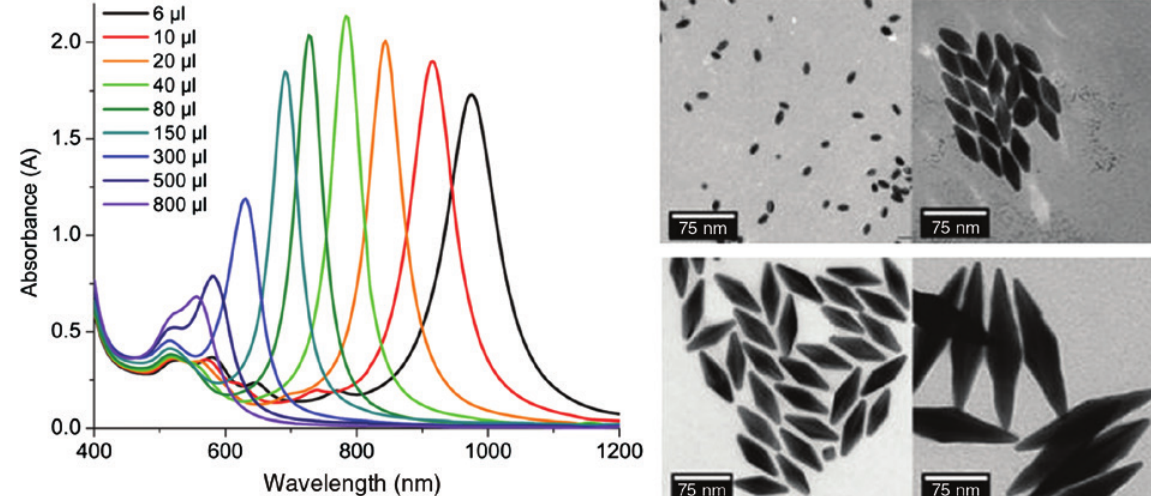
Figure 11: Left: Absorption spectra of the synthesized bipyramids versus the volume of seed solution added. Right: TEM of bipyramids prepared with CTAB and 800, 80, 40, and 6 μ l of seed suspension. Reproduced from Ref. [84] with permission from The Royal Society of